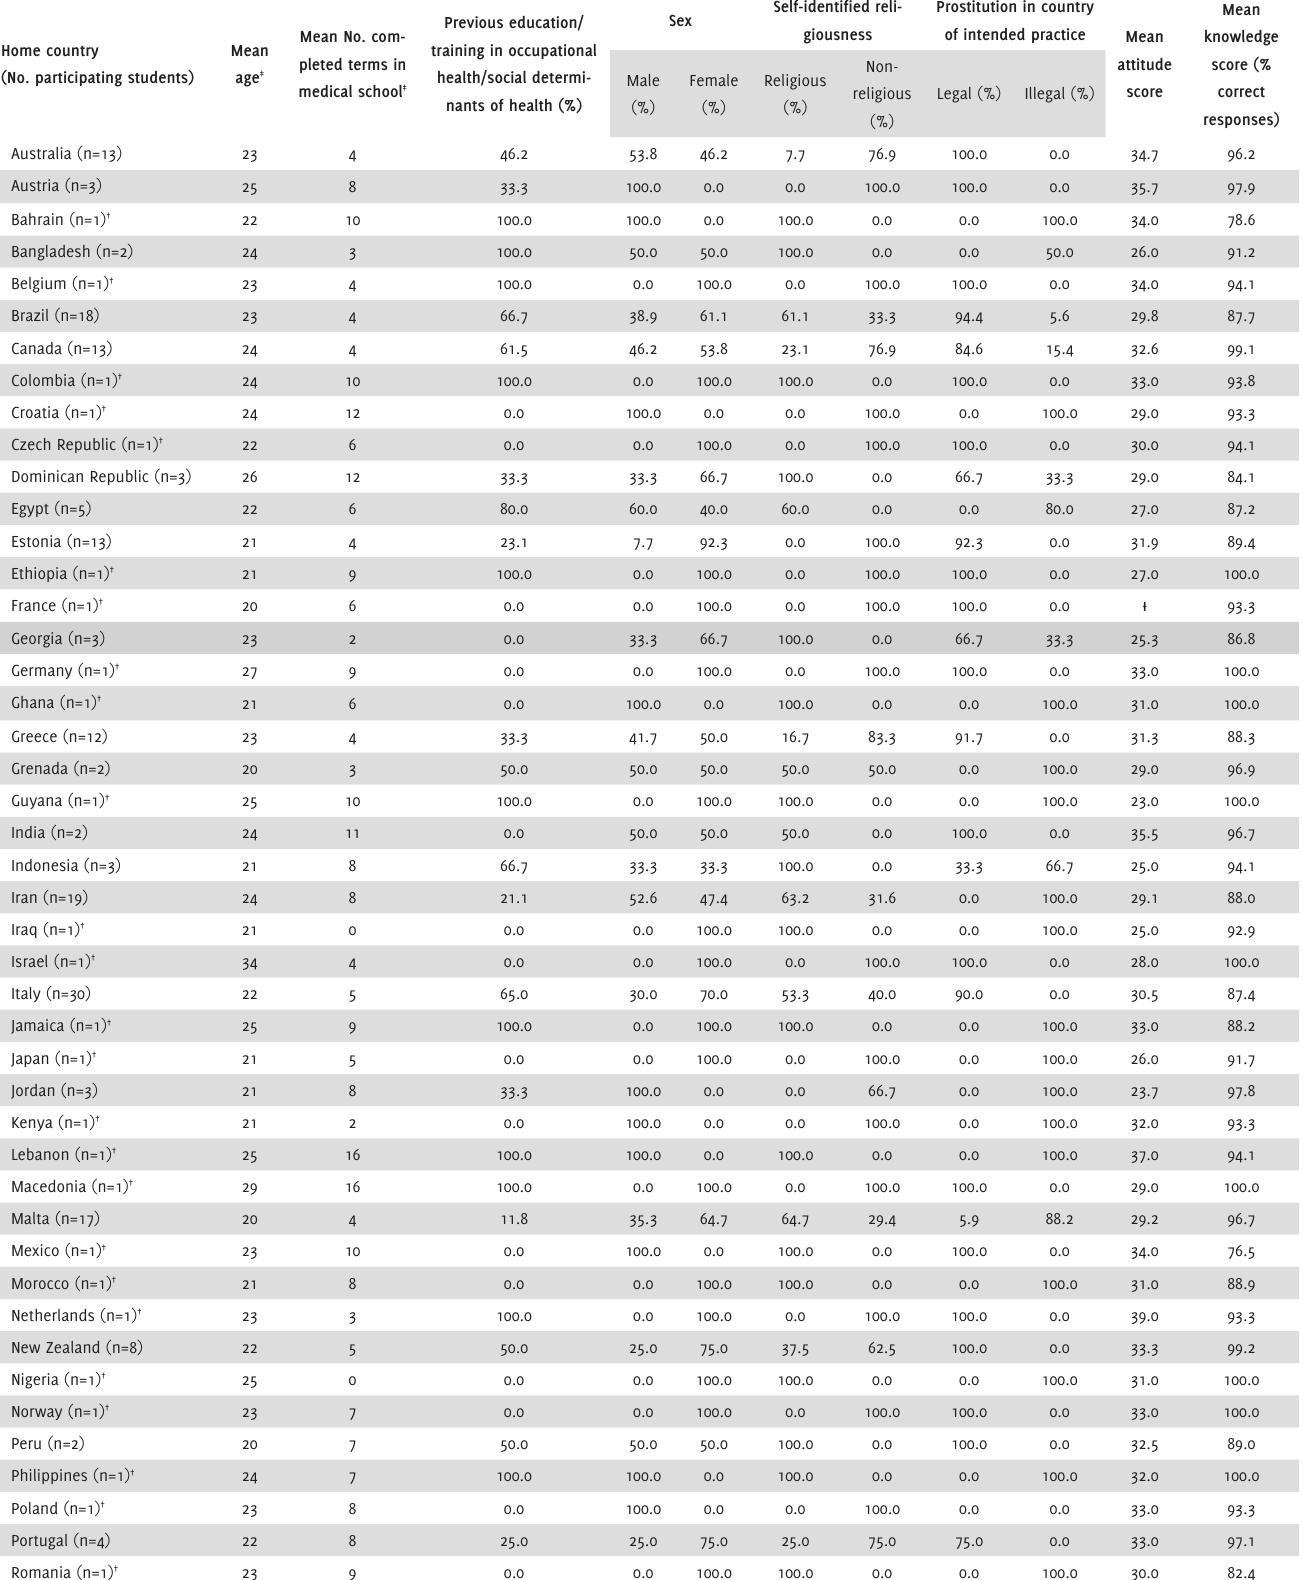
Table 1. Participating Countries’ Demographics, Mean Attitude Scores, and Mean Knowledge Scores.